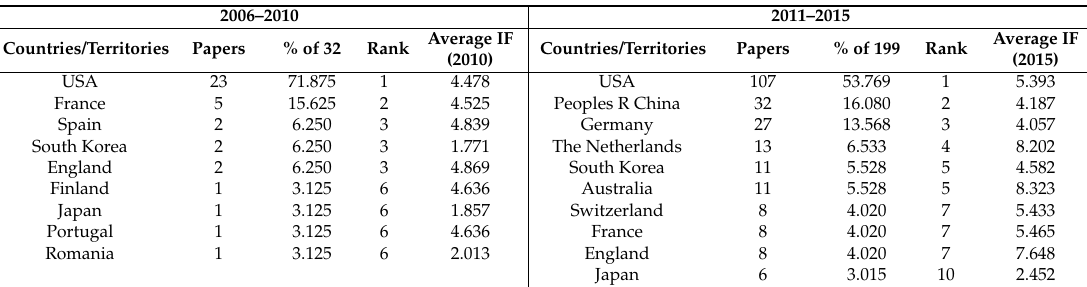
Table 2. Top 10 publishing countries during the periods 2006–2010 and 2011–2015 (IF: impact factor). The countries publishing bioprinting research are displayed in decreasing order according to the number of publications for each time